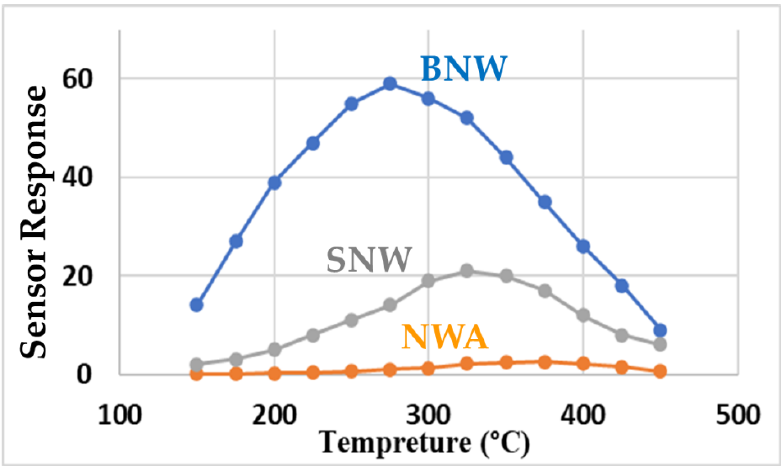
Figure 1. Sensor response versus operating temperature curves of the three sensors at 200 ppm of acetone.